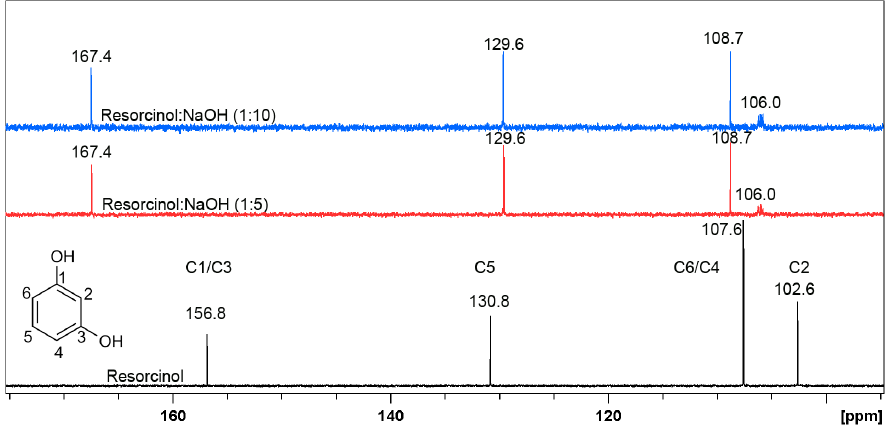
Figure 9. 13 C-NMR spectra of resorcinol in D 2 O (black line) and in the presence of NaOH in D 2 O in molar ratio 1:5 (red line) and 1:10 (blue line), respectively.